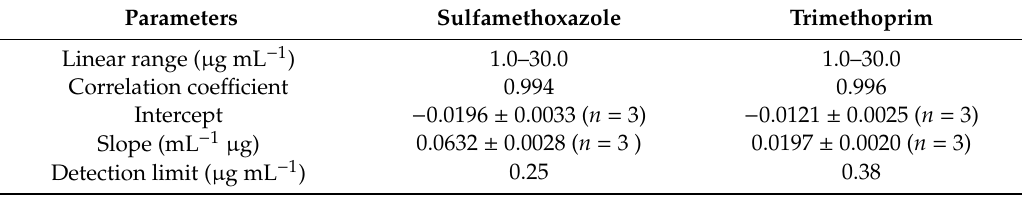
Table 1. Calibrations and figures of merit for sulfamethoxazole (SMX) and trimethoprim (TMP).